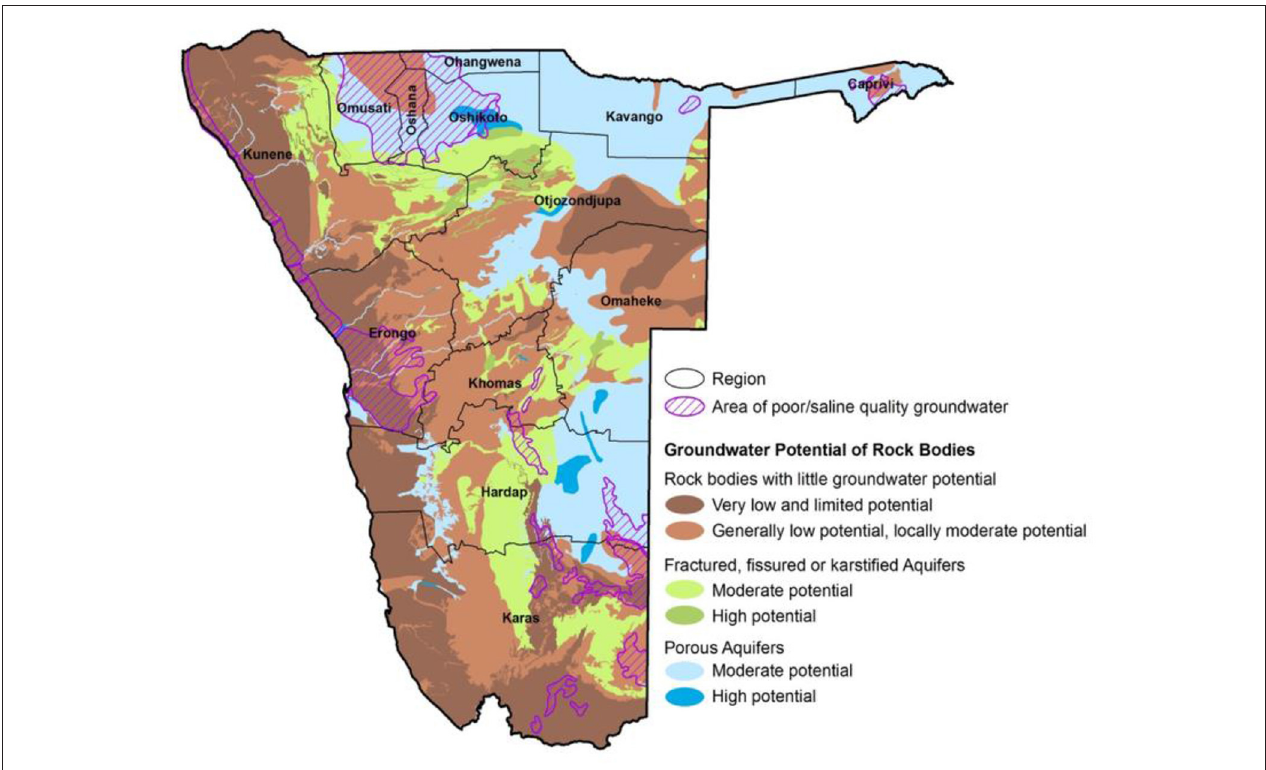
FIGURE 1 | Hydrogeological map of Namibia. Source: Christelis and Struckmeier (2011).